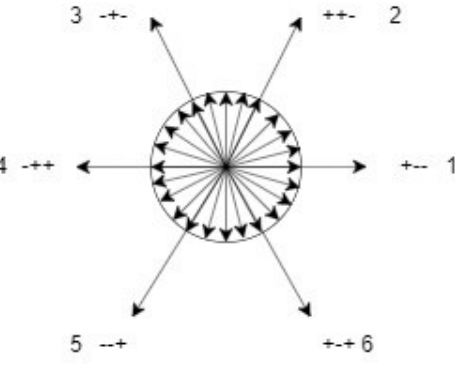
Figure 5. Space vector modulation.